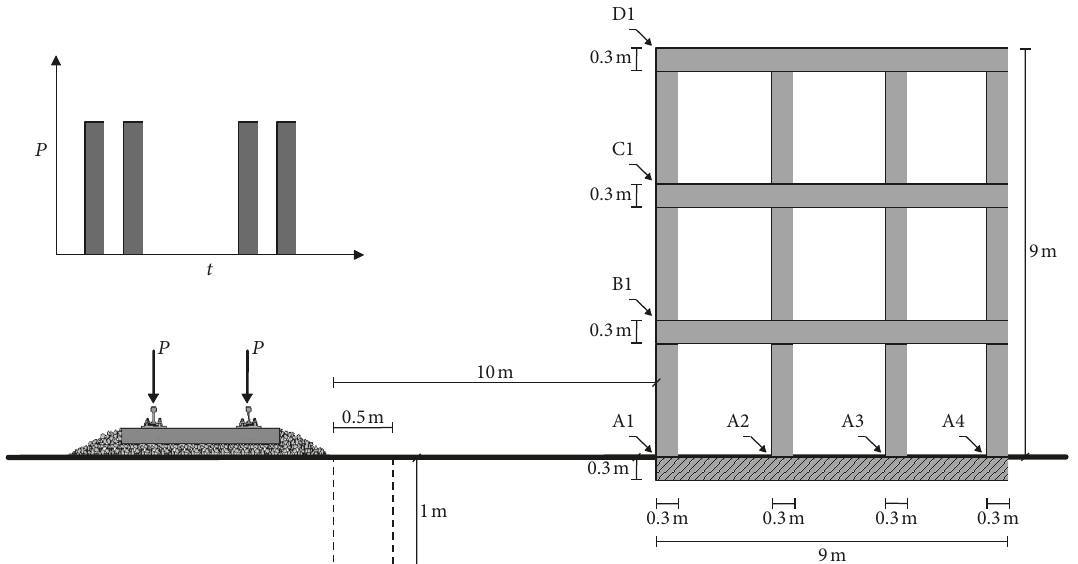
Figure 1: Scheme of the track-soil-building setup and the applied load.